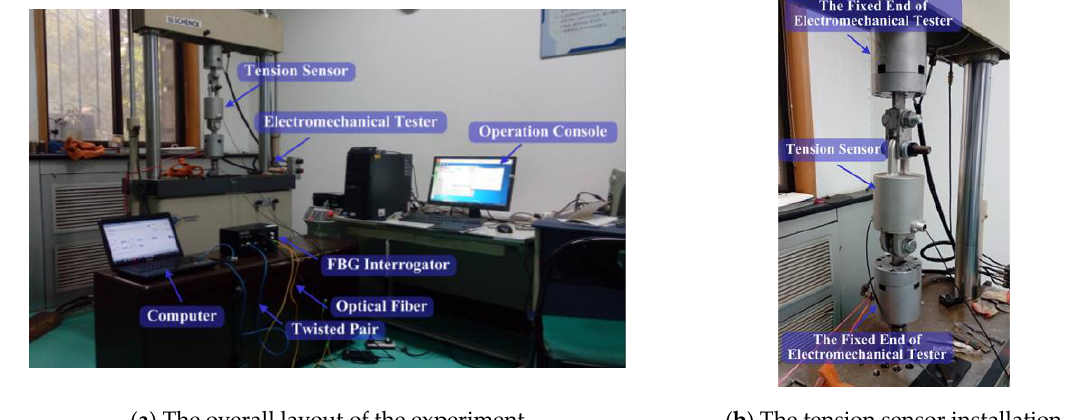
Figure 4 . The setup of the dynamic stretched experiment. Figure 4. The setup of the dynamic stretched